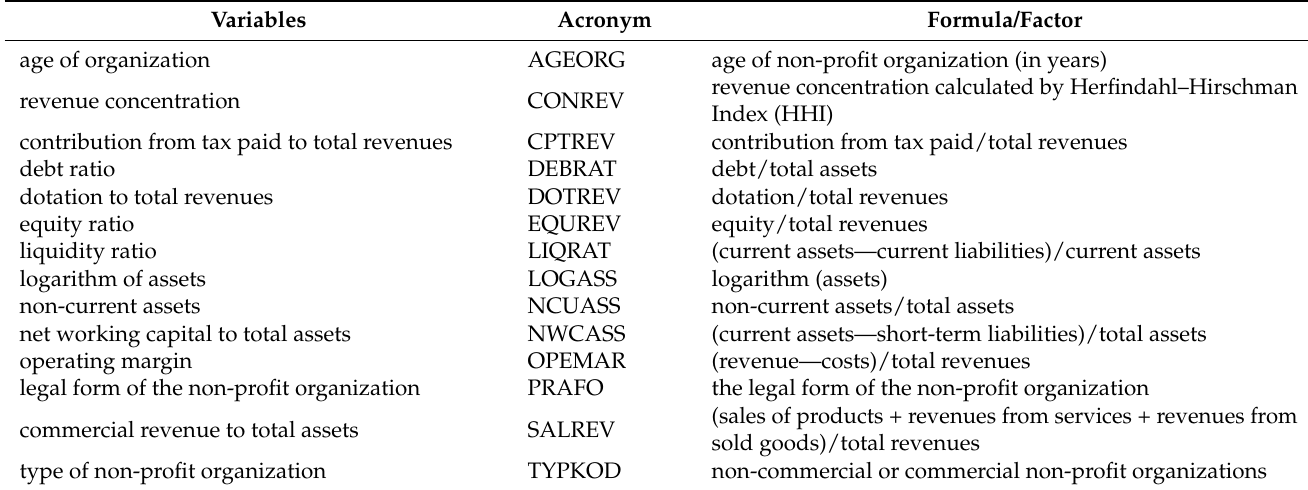
Table 3. Independent